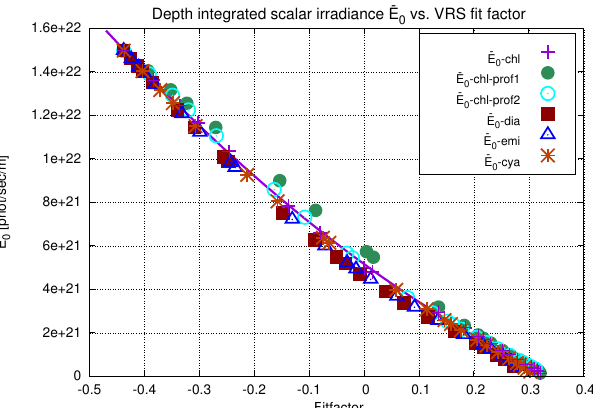
Figure 9. Resulting relationship between the VRS fit factor (cid:49)q v and E 0 , derived according to Eq. (32) for different phytoplankton types and profiles as in Fig. 8. The solid magenta line is a fitted third-order polynomial to the reference scenario (magenta points) with a SZA of 40 ◦ and is used as a LUT for the satellite data re-